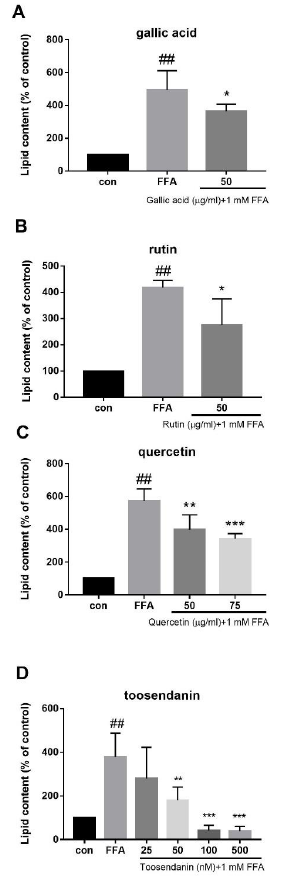
Figure 11. Effects of compounds isolated from T. sinensis on lipid accumulation in HepG2 cells. ( A – D ) Nile red staining. Data were quantified for three to eight independent experiments and expressed as mean ± SD. ## P < 0.01 compared with the control group (con). * P < 0.05 and ** P < 0.01 compared with the FFA group.